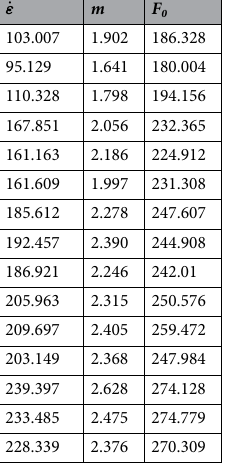
Table 6. Distribution parameter calculation results.